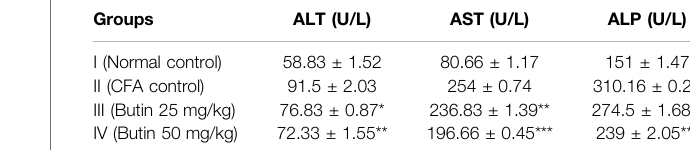
TABLE 1 | Effect of butin on liver enzymes (ALT, AST, and ALP) in experimental animals.